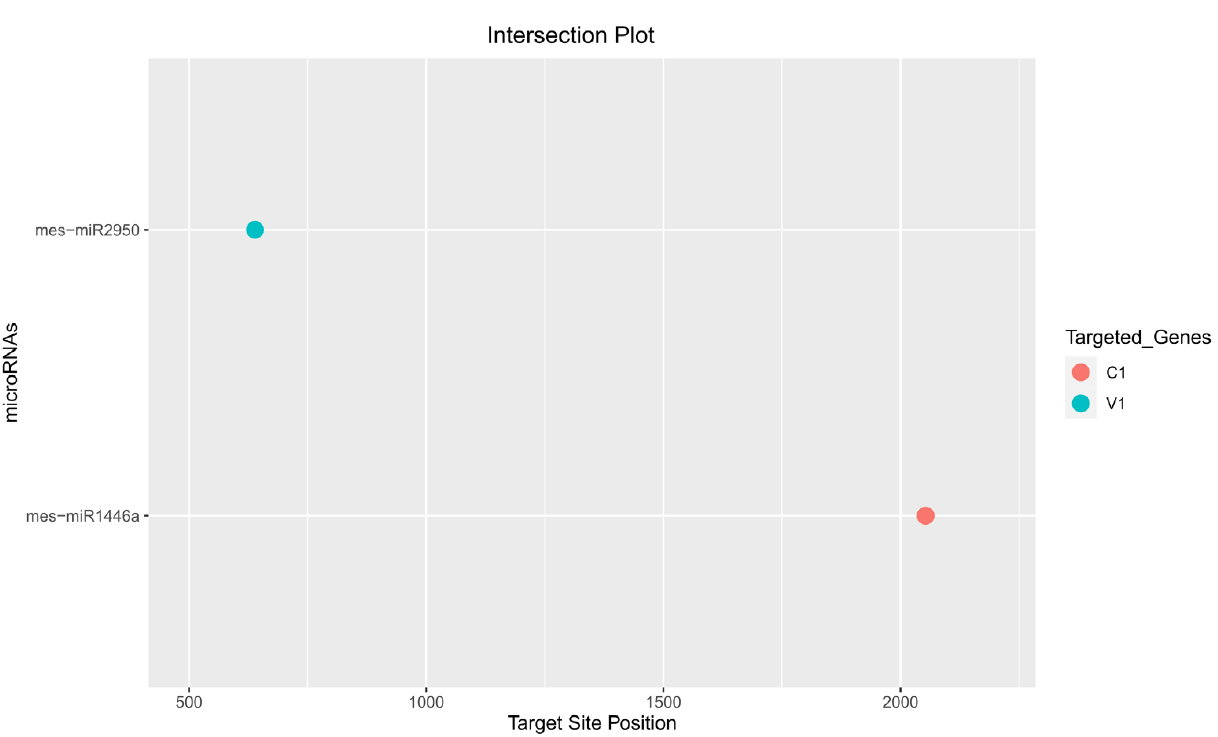
Figure 4. Intersection plot representing consensus cassava miRNAs predicted by at least three algorithms at common genomic loci targeting specific ICMV-Ker genes. The red dot represents cassava miRNA (mes-miR1446a) targeting C1 gene of ICMV-Ker, which was predicted by the four algorithms in this study. Table 4. Predicted consensus cassava locus-derived mes-miRNA binding sites targeting genes en- coded by the ICMV-Ker genome.